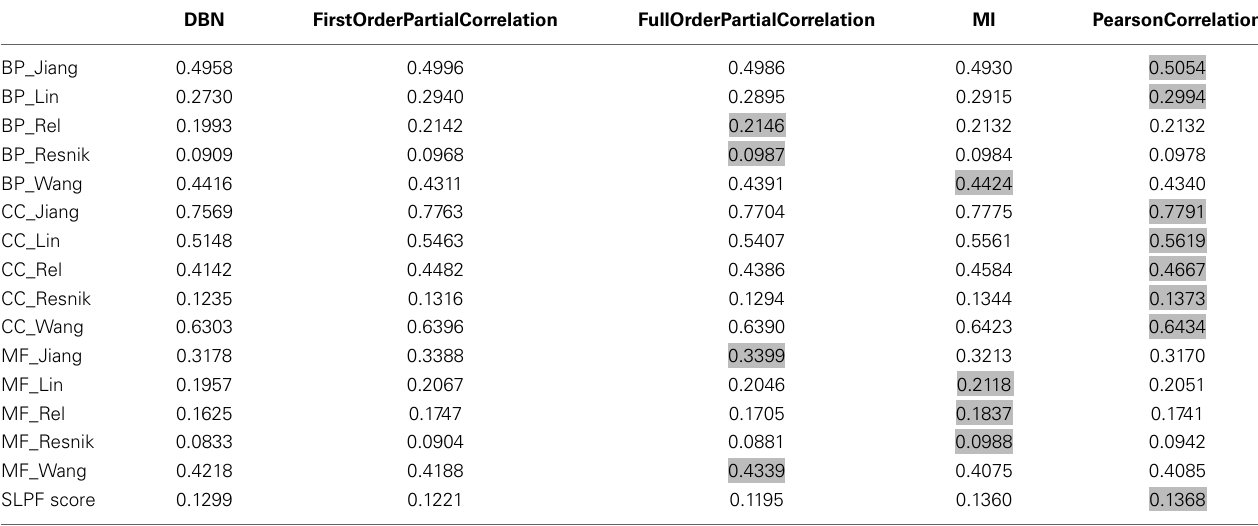
Table 3 | Accuracy scores of the reconstructed networks with same size generated by different methods using the subcellular location pair frequency (SLPF) metric and semantic similarity of gene ontology terms (BP, CC, and MF). DBN MI